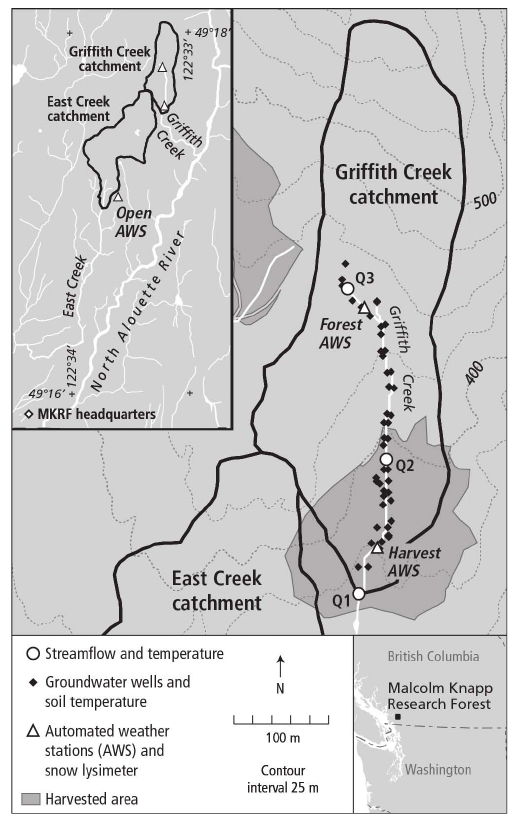
Fig. 1. Map of Griffith Creek and East Creek study